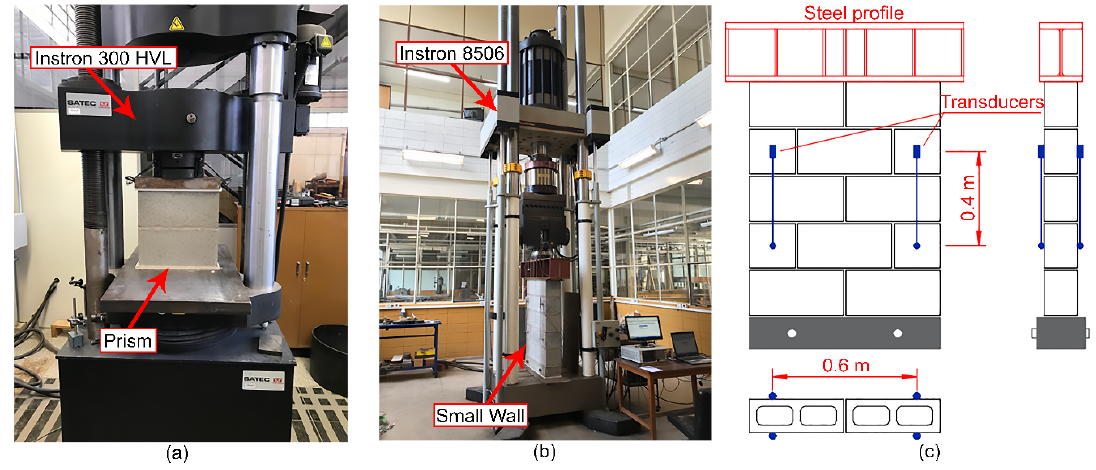
Figure 2. Compression tests of blocks, prisms and small walls at room